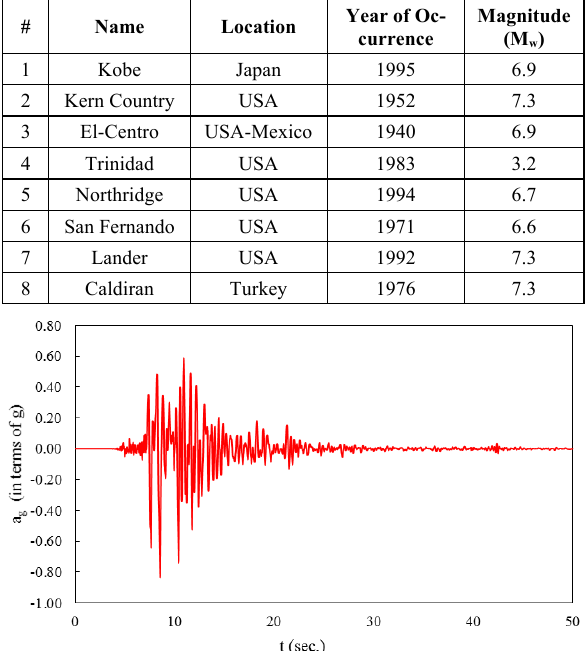
Figure 2. Sample rule base of one of the three parallel fuzzy control- lers.